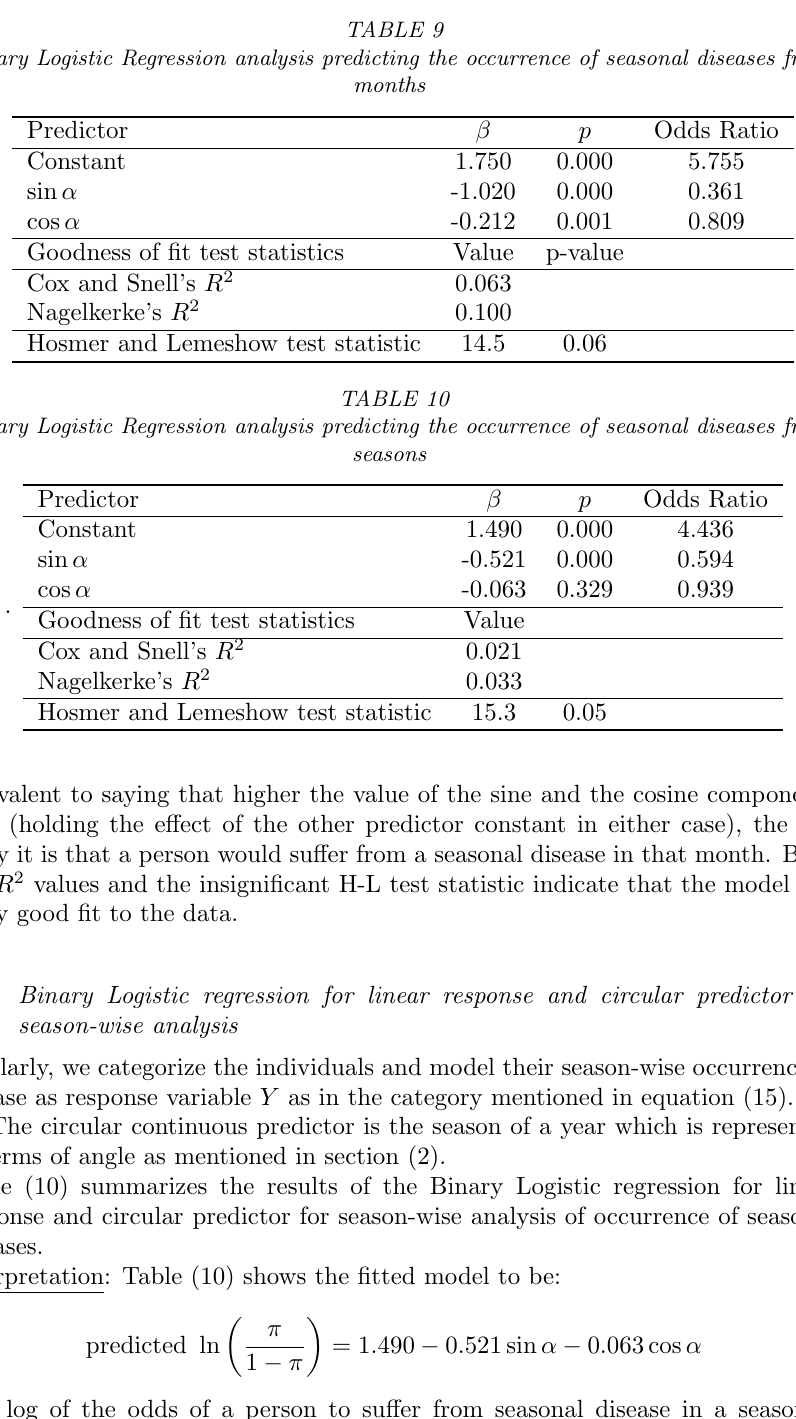
Binary Logistic Regression analysis predicting the occurrence of seasonal diseases from months